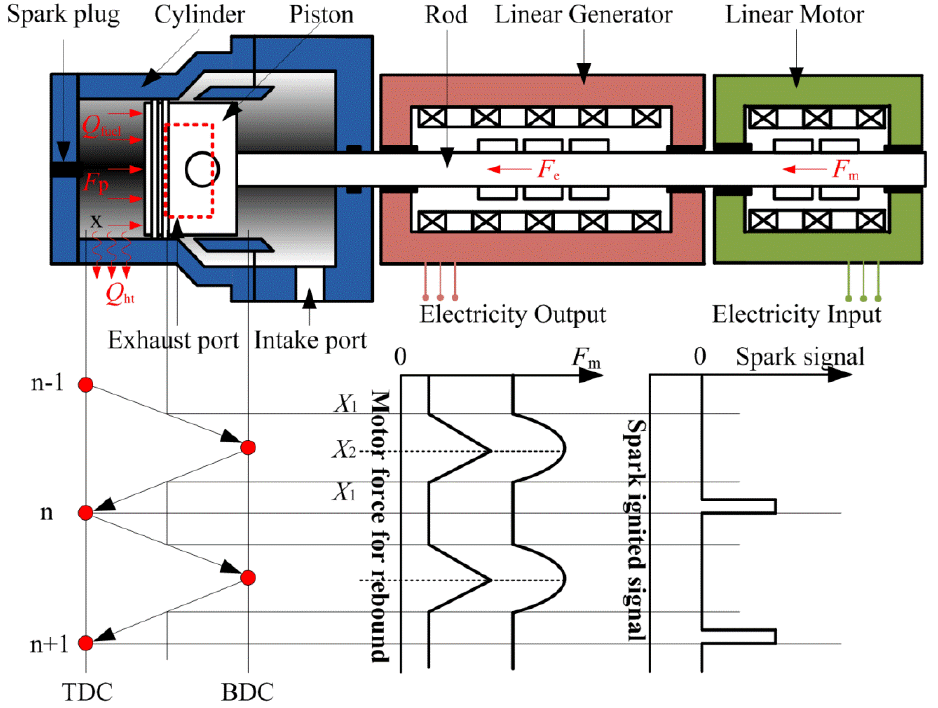
Figure 1. Configuration of a single-cylinder